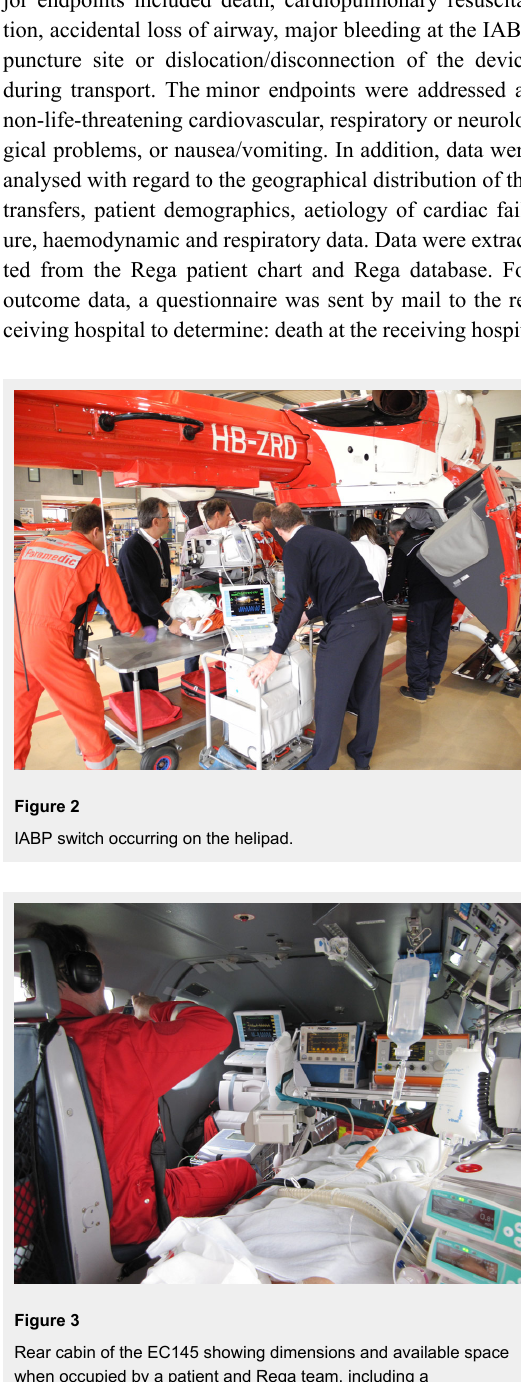
Rear cabin of the EC145 showing dimensions and available space when occupied by a patient and Rega team, including a